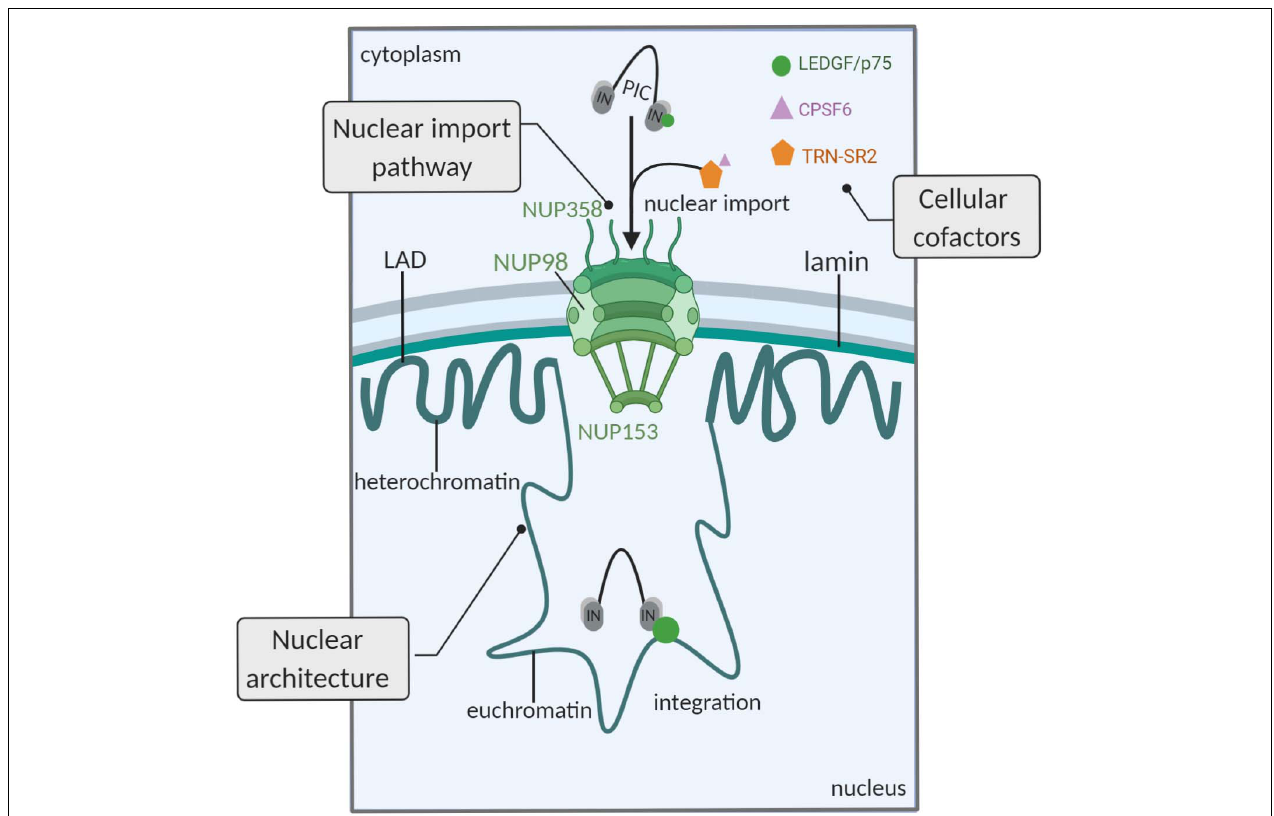
FIGURE 1 | Determinants of HIV-1 integration site selection. The HIV-1 nuclear import pathway is linked to integration. The HIV-1 PIC engages NUPs, favoring integration in close proximity to the NPC (upper left part). Second, cellular cofactors affect the proviral integration site. LEDGF/p75 interacts with HIV-1 IN and targets integration toward active genes. The HIV-1 PIC interacts with other cellular cofactors that affect integration: TRN-SR2 and CPSF6 have been associated with integration in gene-dense regions. TRN-SR2 mediates nuclear import of SR proteins, such as CPSF6, and interacts with the viral IN. The exact mechanism by which these proteins affect nuclear import and integration is not completely understood yet (upper right part). Third, the nuclear architecture affects integration site selection. The heterochromatin condensed regions in the LADs are disfavored, while gene-rich and euchromatin regions in close association with the NPC are frequently targeted by HIV-1 (lower part). PIC, pre-integration complex; NUPs, nucleoporins; LEDGF/p75, lens-epithelium-derived growth factor; IN, integrase; TRN-SR2, transportin-SR2; CPSF6, cleavage and polyadenylation specificity factor 6; LAD, lamina-associated domains; figure created with